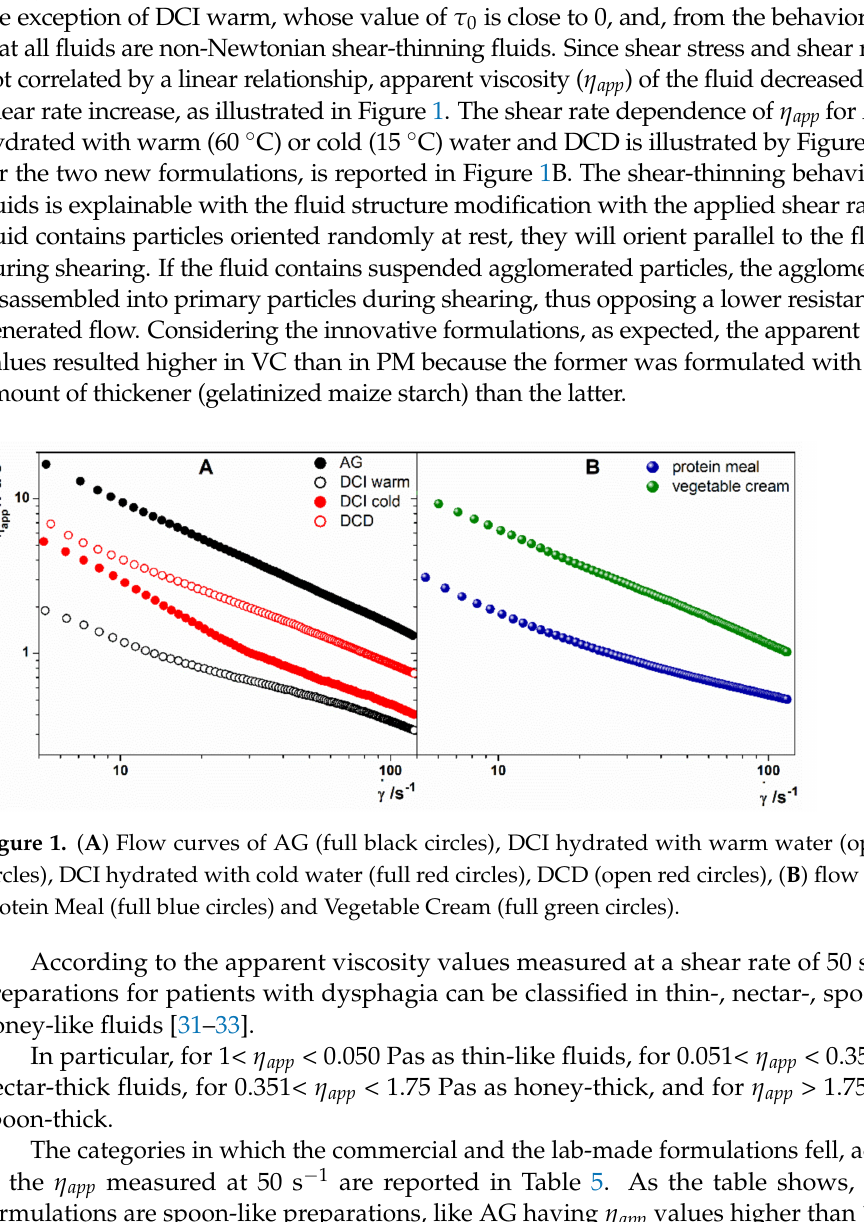
. γ = 50 s − 1 and formulation category for commercial